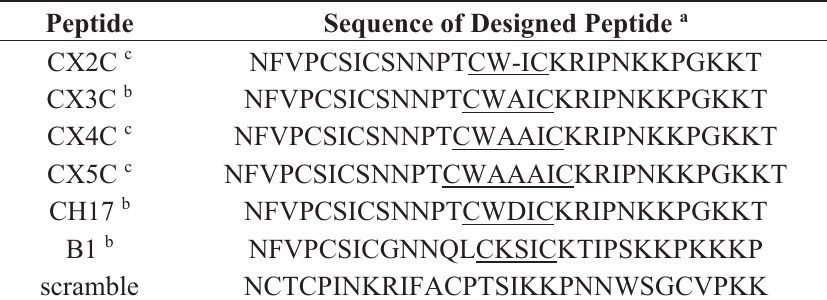
Table 1. RSV G 169–198 peptides used for vaccination.